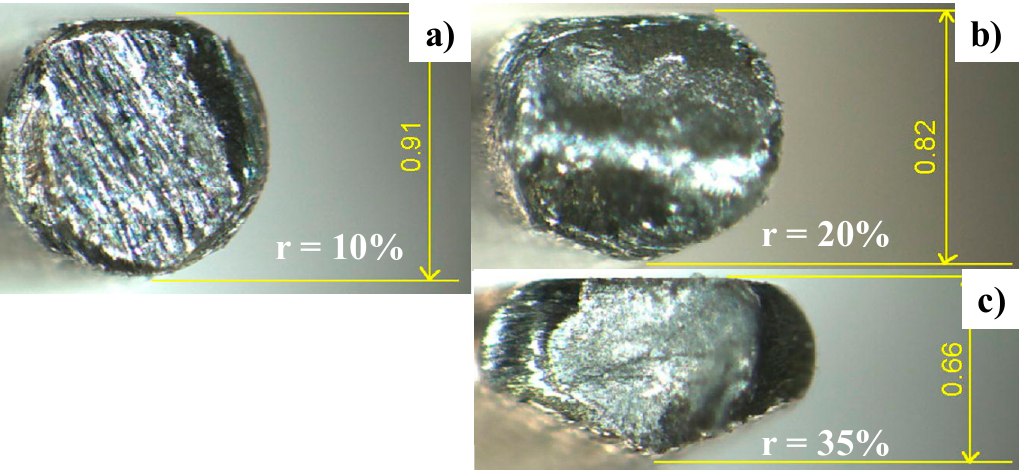
Figure 8. Variation of the cross-section of forged titanium wires by forging with increasing the reduction of the diameter. ( a ) r = 10%, ( b ) r = 20% and ( c ) r = 35%.